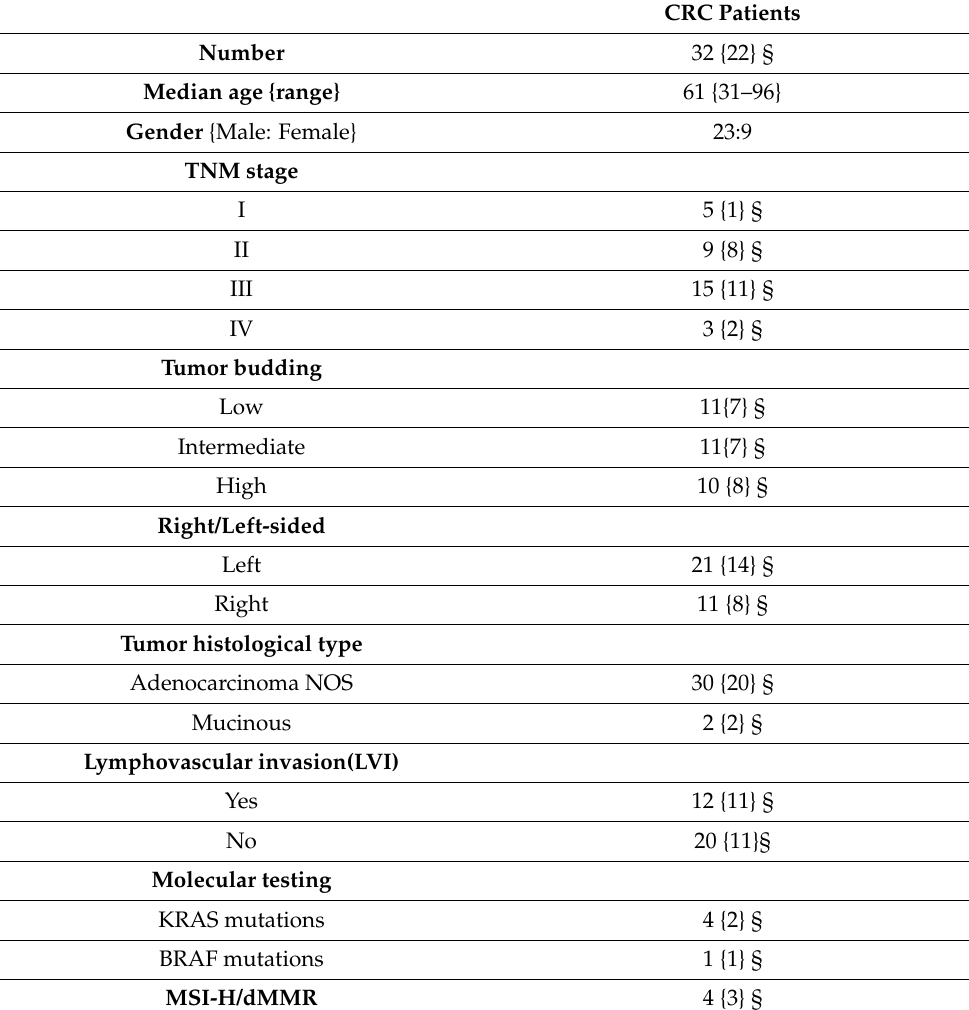
Table 1. Characteristic features of colorectal cancer